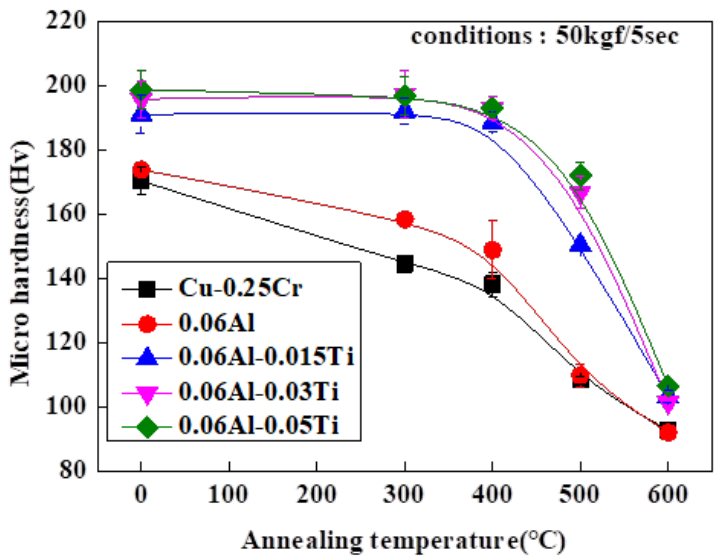
Figure 10. Variation of resistance to softening characteristics of Cu-Cr alloys.